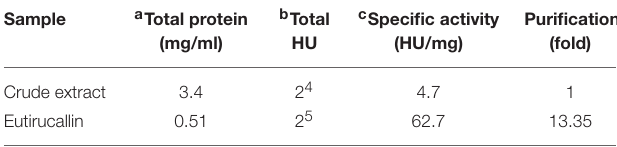
TABLE 2 | Purification efficiency of